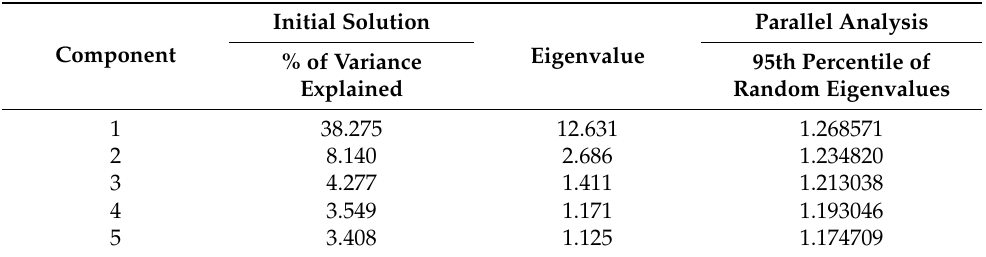
Table 4. Extracted principal components with Eigenvalues, percentage of explained variance, and parallel analysis criterion—committing cyber-violence